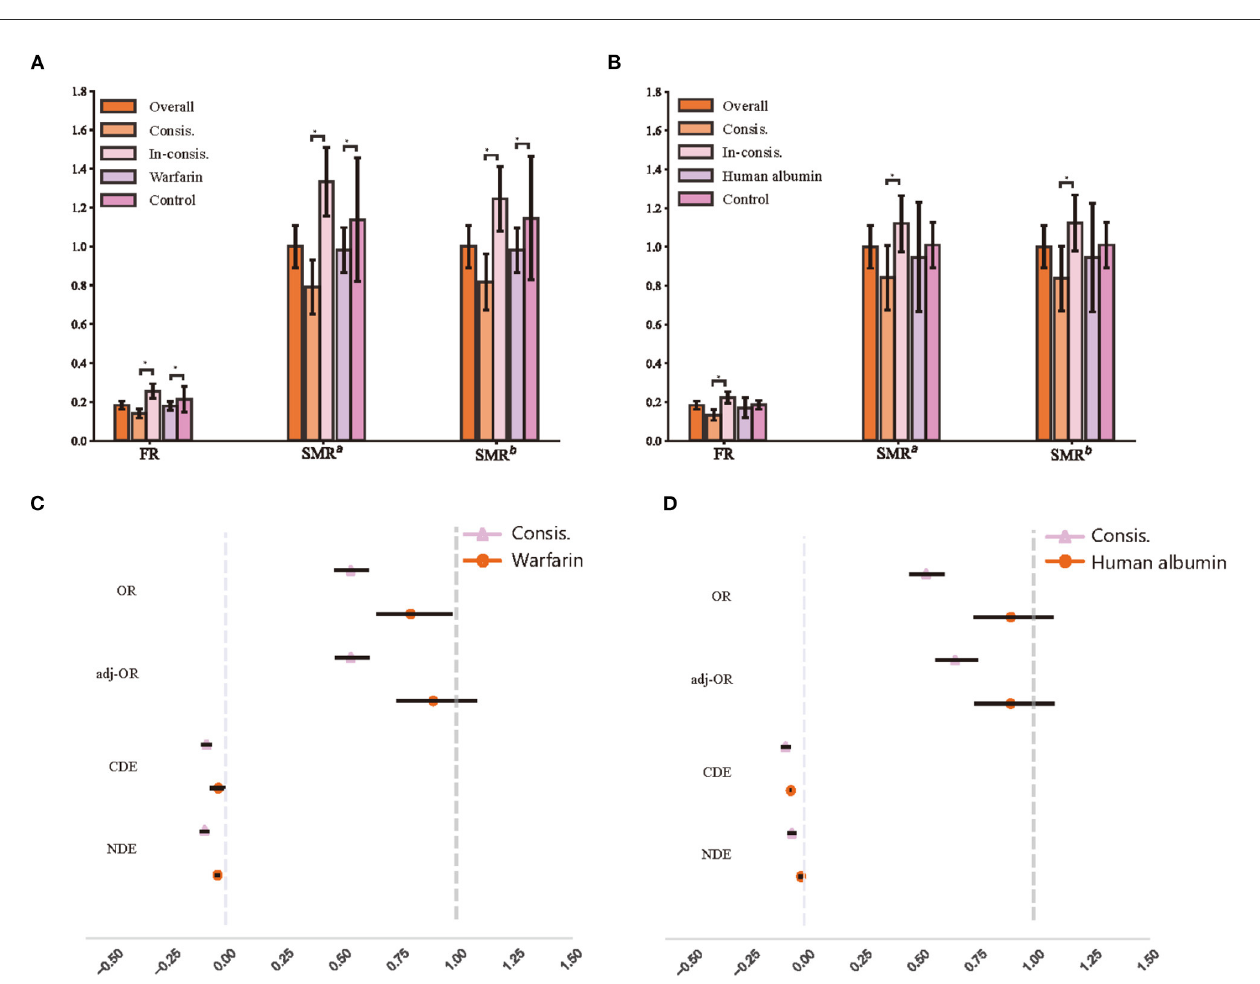
FIGURE3 The recognition of treatment heterogeneity effects. (A) Fatality of different warfarin treatment groups; (B) Fatality of different human albumin treatment groups; (C) The average treatment effects of warfarin treatment groups; (D) The average treatment effects of human albumin treatment groups. FR, fatality rate; SMR, standardized mortality rate; SMR a , standardized mortality rate that controls age and sex; SMR b , standardized mortality rate that controls age, sex, and all subtypes of stroke; OR, odds ratio; adj-OR, odds ratio that adjusted with augmented inverse probability weighting; CDE, controlled direct effect; NDE, natural direct